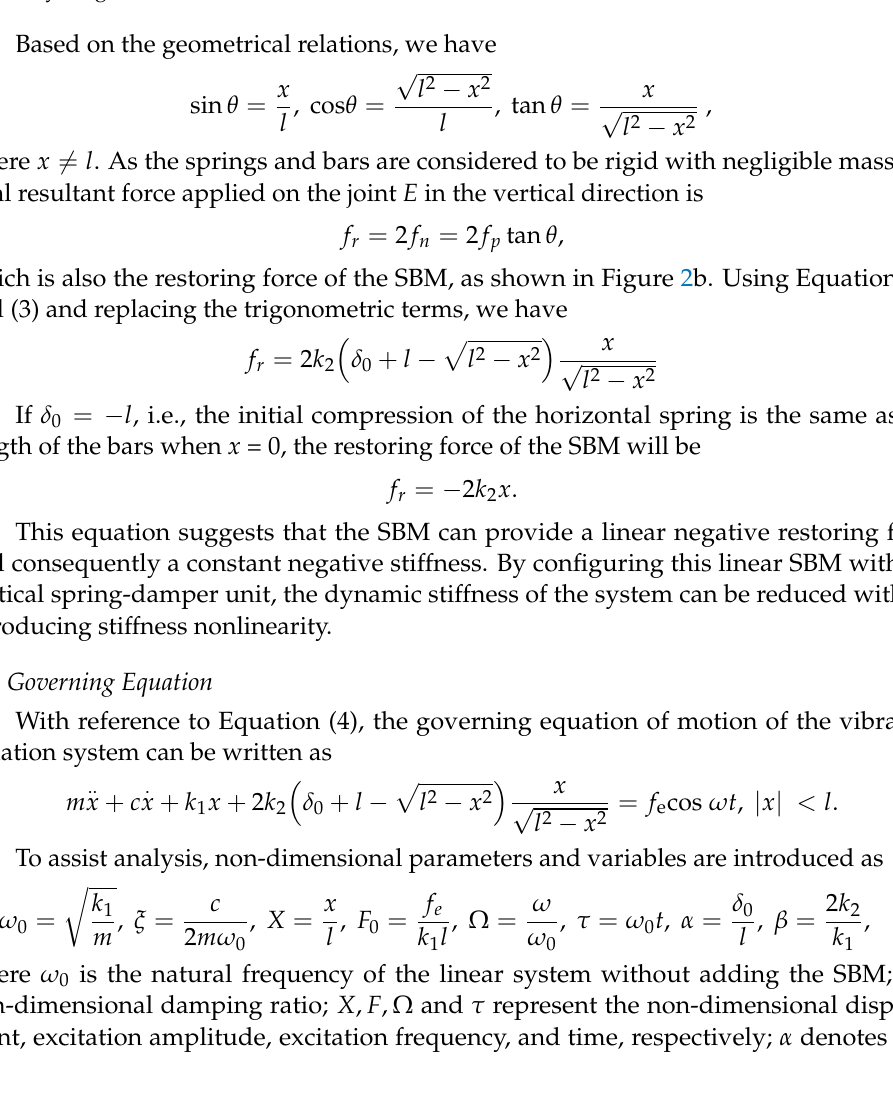
Figure 2. A schematic representation of the SBM system with ( a ) the geometrical deflection and ( b ) a free-body diagram of the